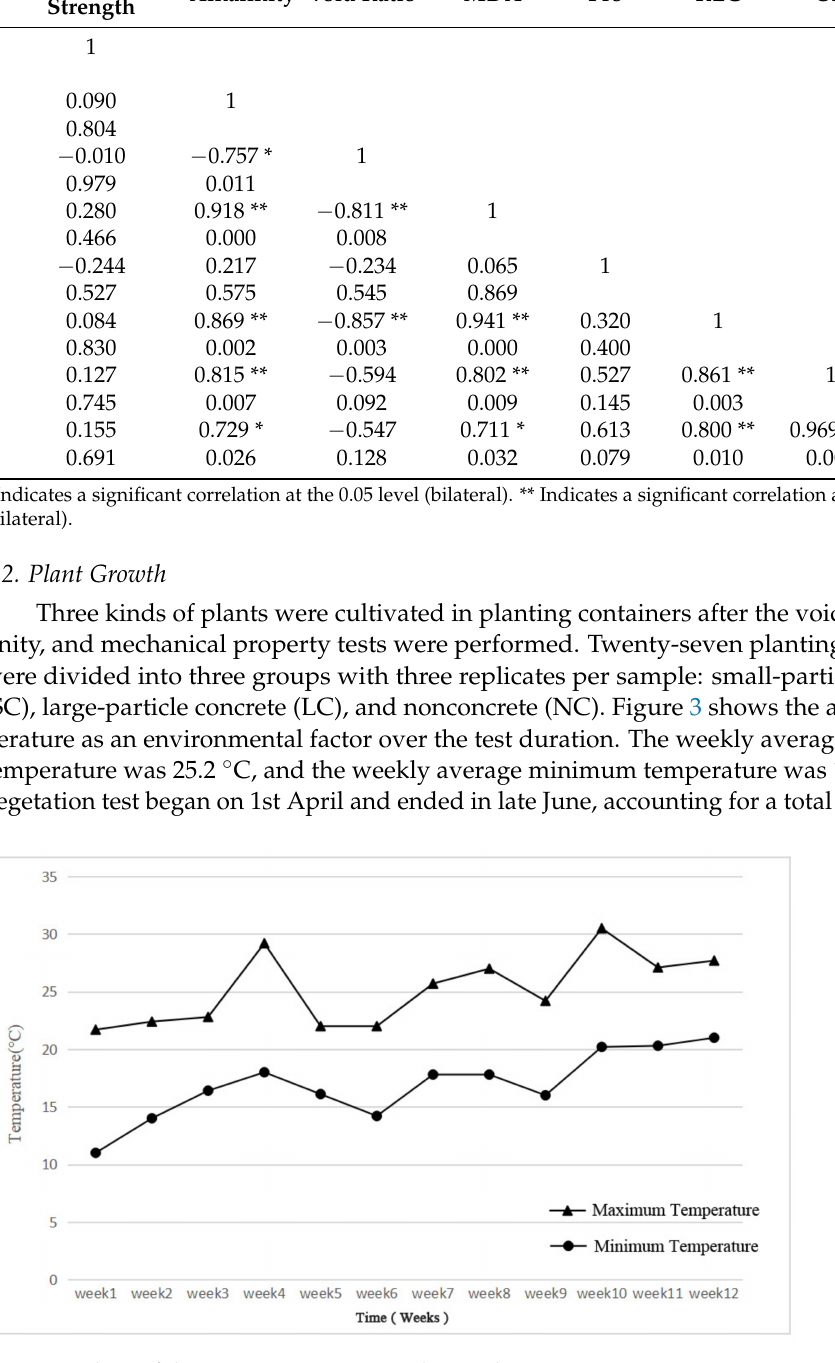
Figure 3. Chart of the average temperature during the vegetation